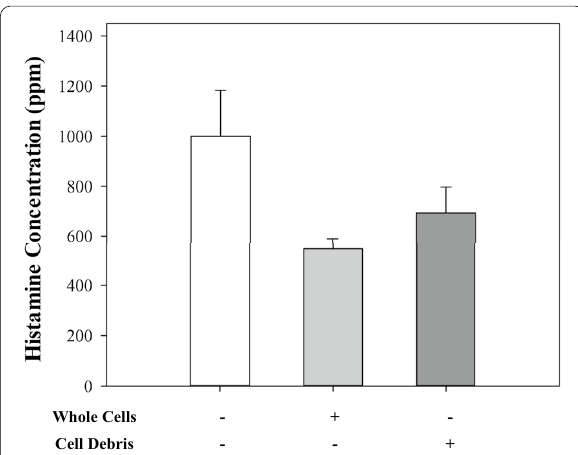
Fig. 4 Histamine inhibitory ability in cell debris. The cells were sonicated and reacted with histamine to confirm their inhibitory ability. The result confirmed that the cell debris of GWL‑1 also showed a histamine inhibition as much as for the whole